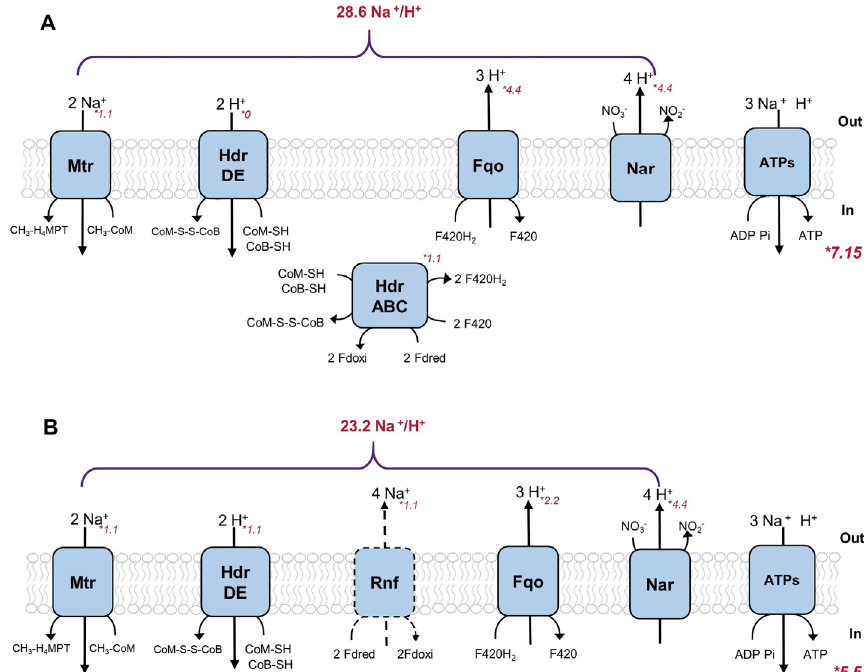
Figure 3. All ion-translocating enzymes of M. nitroreducens in action and the amount of ion translocation. ( A ) Normal energy-conserving related enzymes in nitrate-driven AOM. ( B ) An alternative hypothetical respiratory chain with a pseudo-Rnf reaction (in dashed line) instead of HdrABC. Numbers in italics next to enzymes denote reaction fluxes (mmol gDW − 1 h − 1 ) calculated under ATP